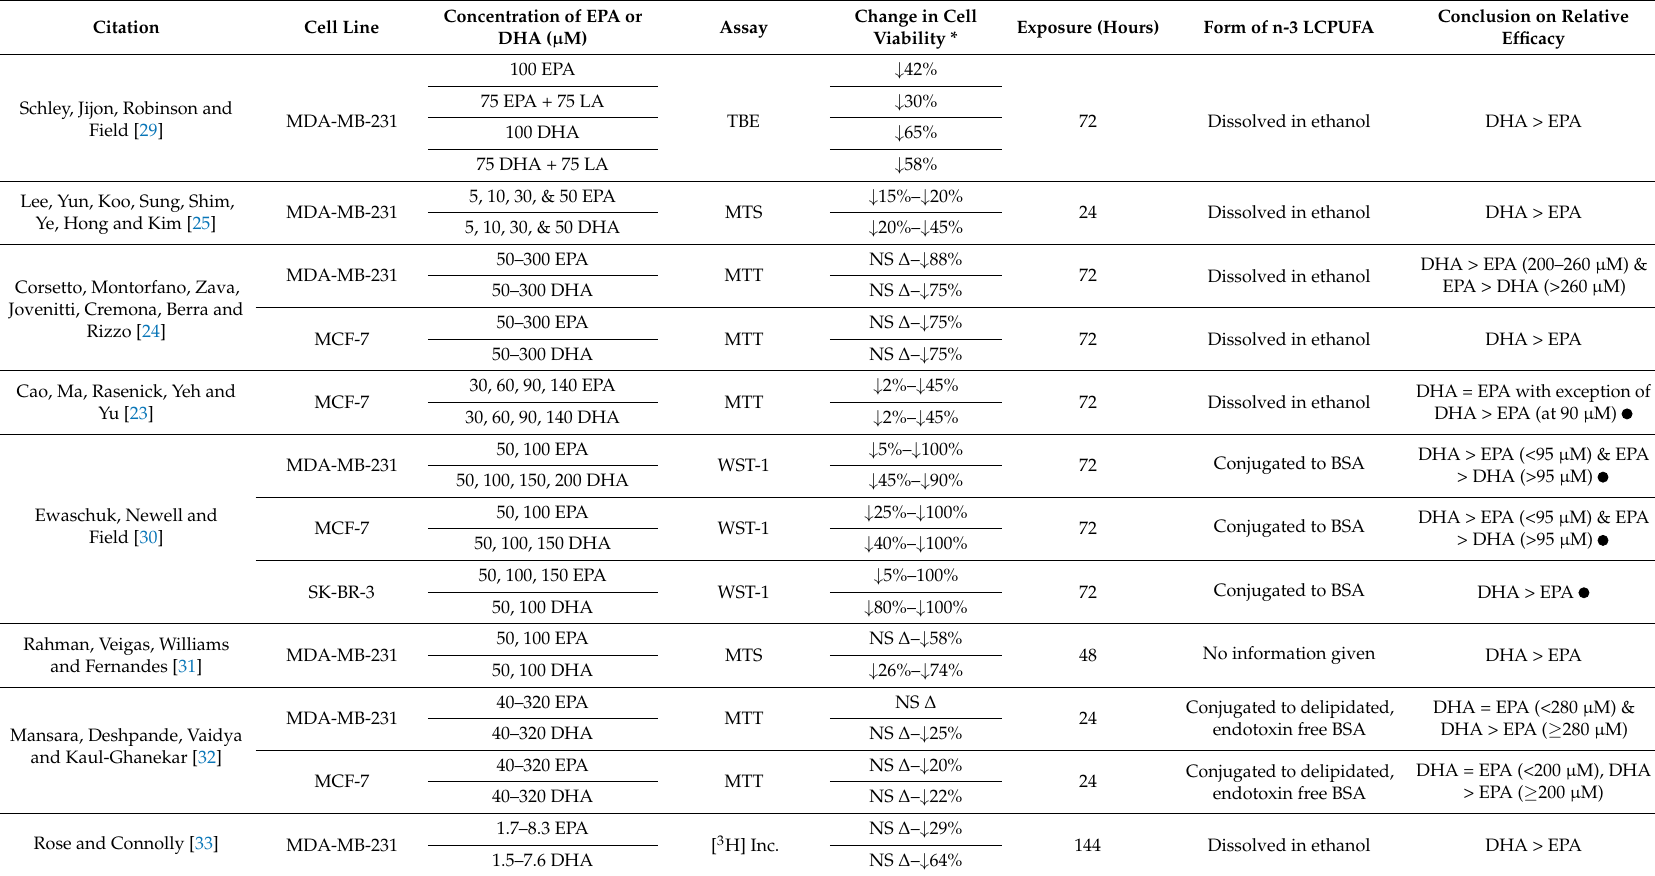
Table 6. Comparison of EPA and DHA on cell growth & viability in human BC cell